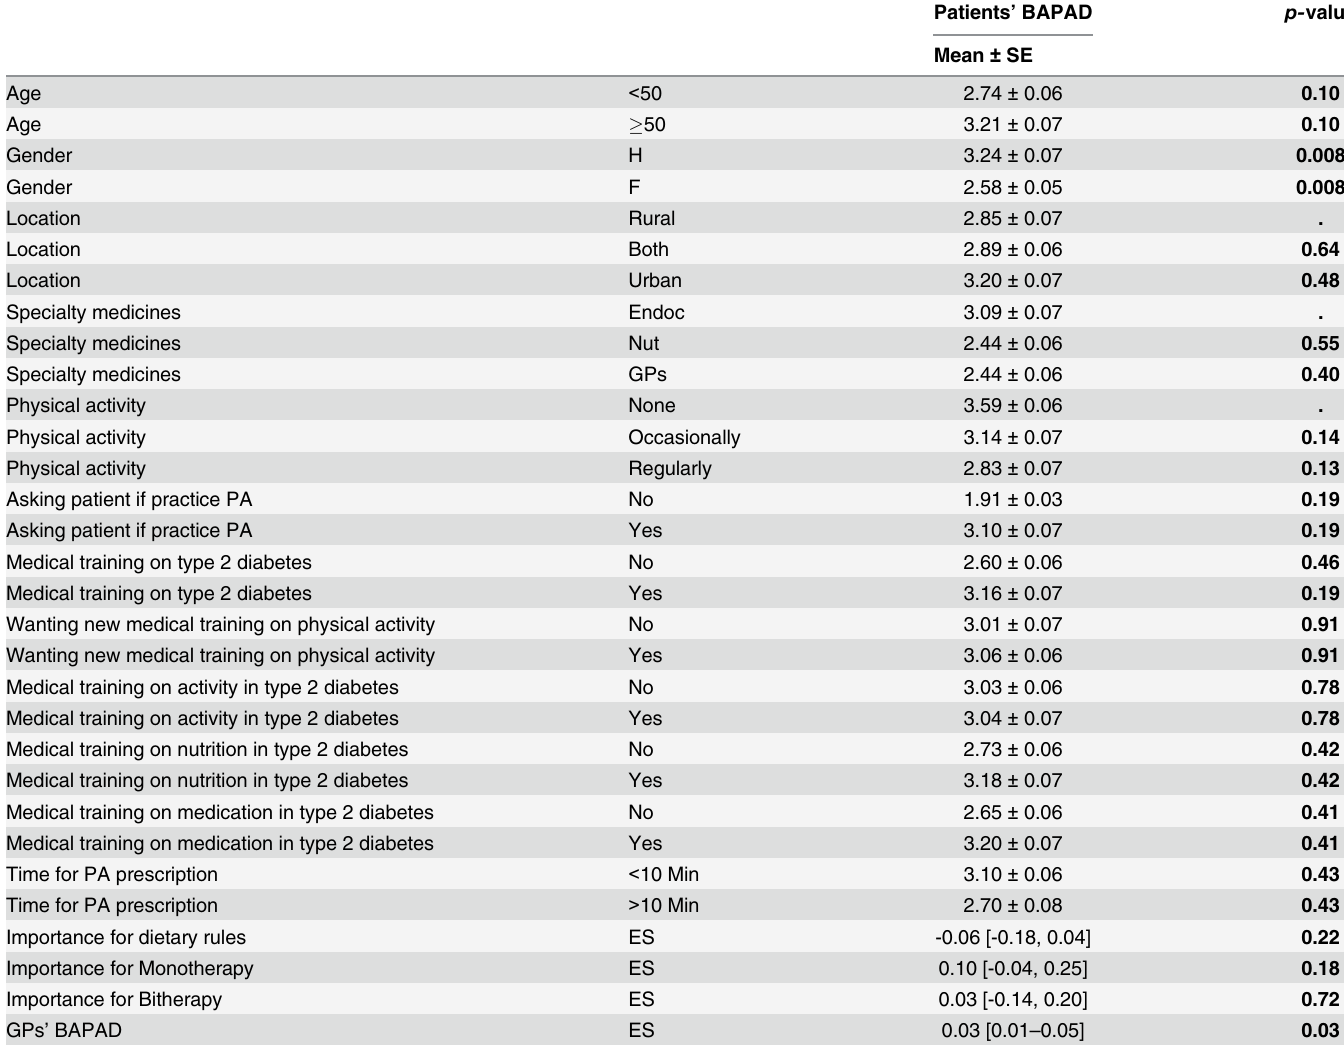
Table 4. Patient ’ s BAPAD according to general practitioner ’ s characteristics (univariate mixed model).